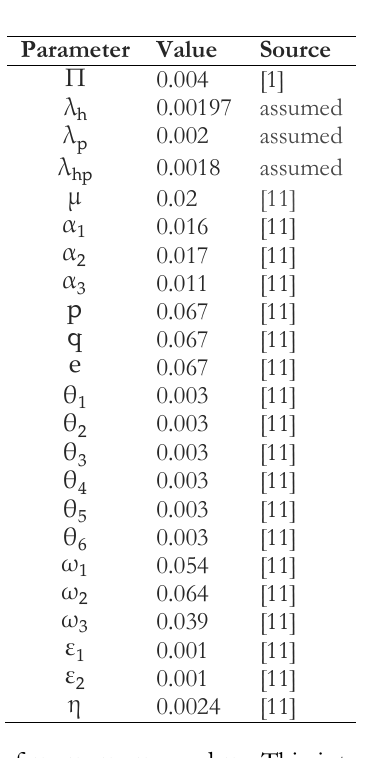
Table 1. Parameter values used in